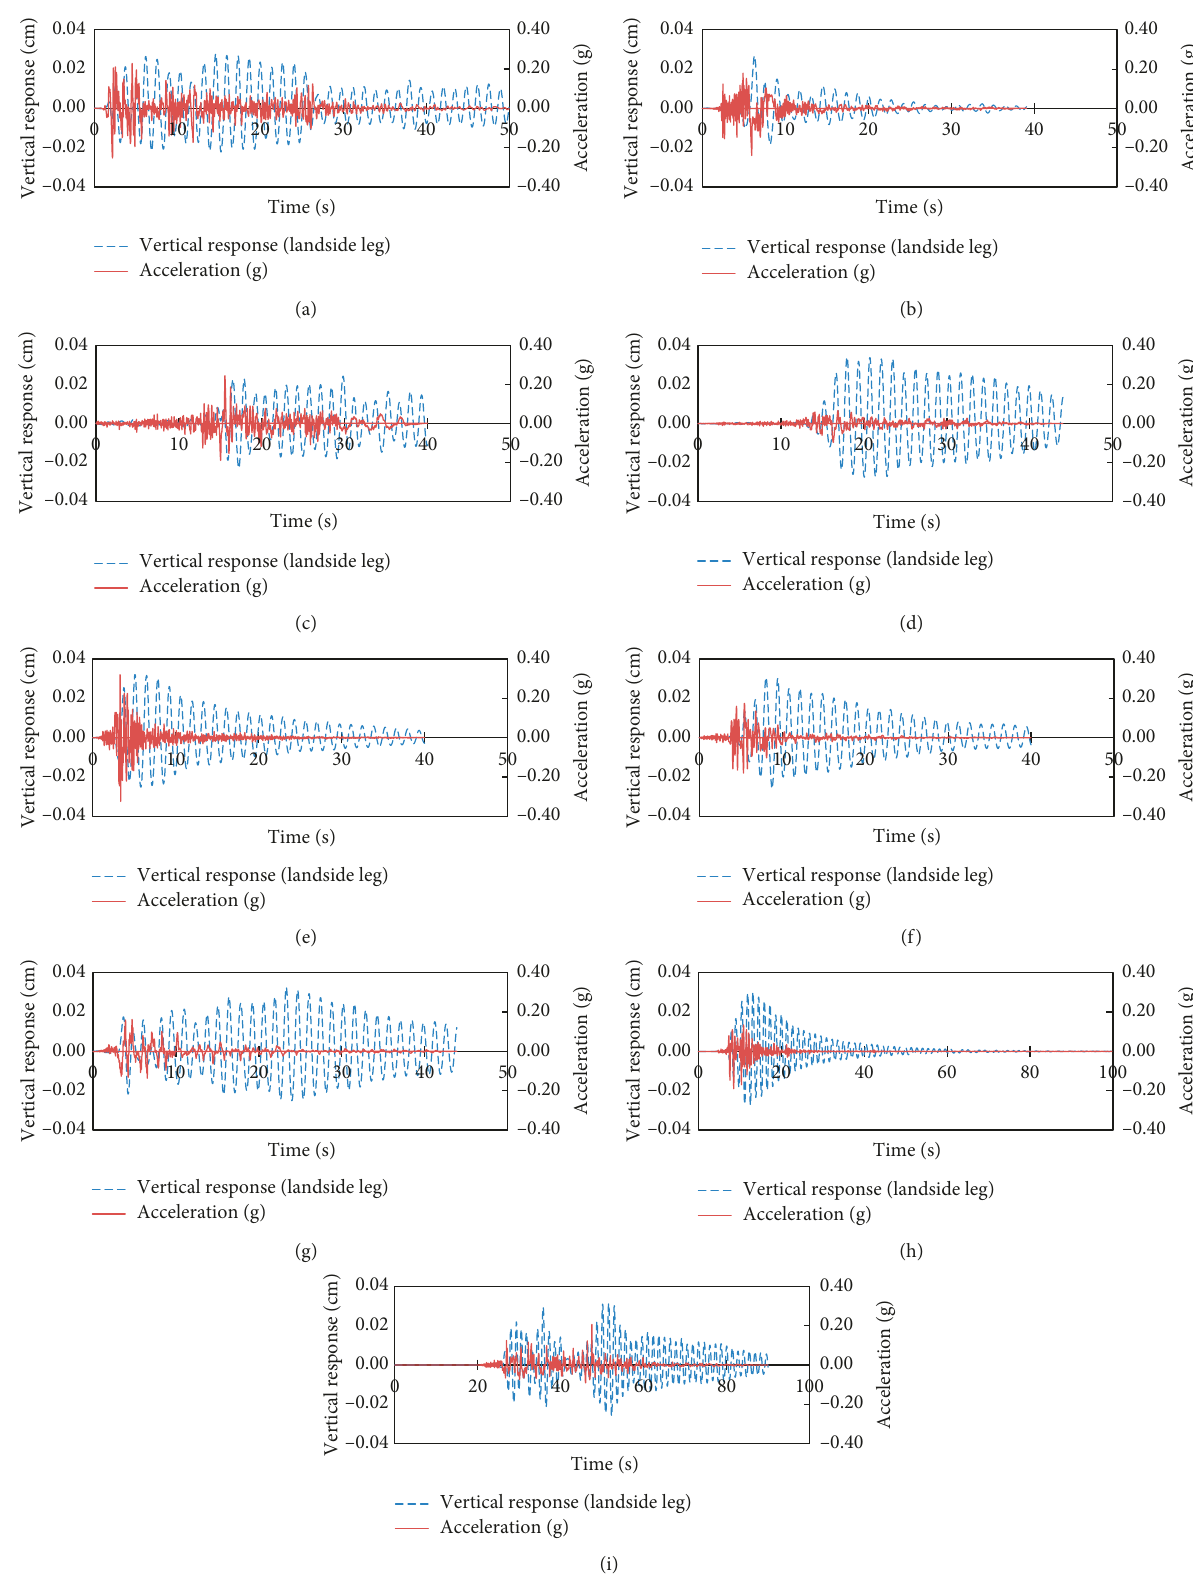
Figure 13: Time-history vertical response of the landside leg (node 20). (a) Imperial Valley-02 (GM-1). (b) Imperial Valley-06 (GM-2). (c) Landers, Barstow (GM-3). (d) Landers, Yermo Fire Station (GM-4). (e) Loma Prieta (GM-5). (f) Northridge-01, Newhall (GM-6). (g) Northridge-01, Sylmar (GM-7). (h) Kobe, Japan (GM-8). (i) Chi-Chi, Taiwan